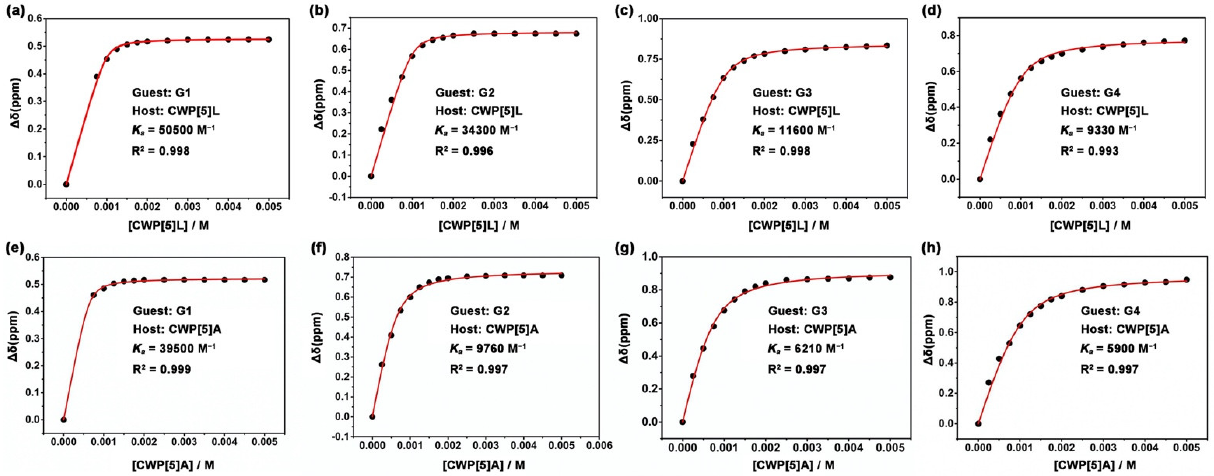
Figure 3. Non-linear curve-fitting (NMR titrations) for the complexation between ( a ) CWP[5]L and G1 , ( b ) CWP[5]L and G2 , ( c ) CWP[5]L and G3 , ( d ) CWP[5]L and G4 , ( e ) CWP[5]A and G1 , ( f ) CWP[5]A and G2 , ( g ) CWP[5]A and G , and ( h ) CWP[5]A and G4 in D 2 O at 298 K. All the titration experiments were repeated thrice with the relative errors less than 15%.